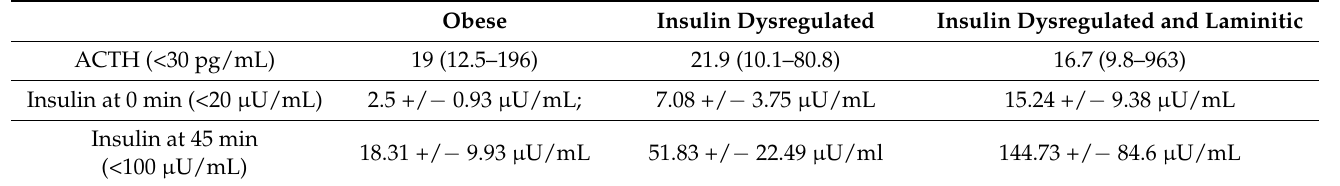
Table 2. ACTH and insulin concentration in obese, insulin dysregulated, and insulin dysregulated laminitic horses (median (minimum-maximum) or mean +/ − standard deviation). Obese Insulin Dysregulated Insulin Dysregulated and Laminitic